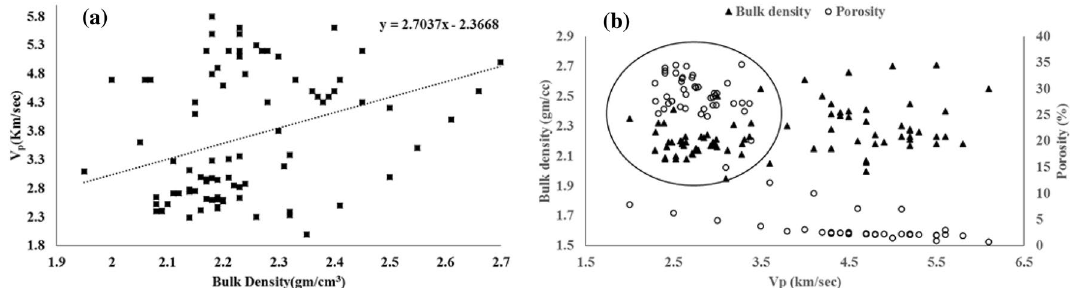
Fig. 4 V p versus bulk density a as reported by different research- ers (Kahraman and Yeken 2008; Soroush et al. 2011; Kurtulus et al. 2016; Kassab and Weller 2015) along with general trend used to cal- culate V p (density) in this study [where Y axis is V p (km/s) and X is